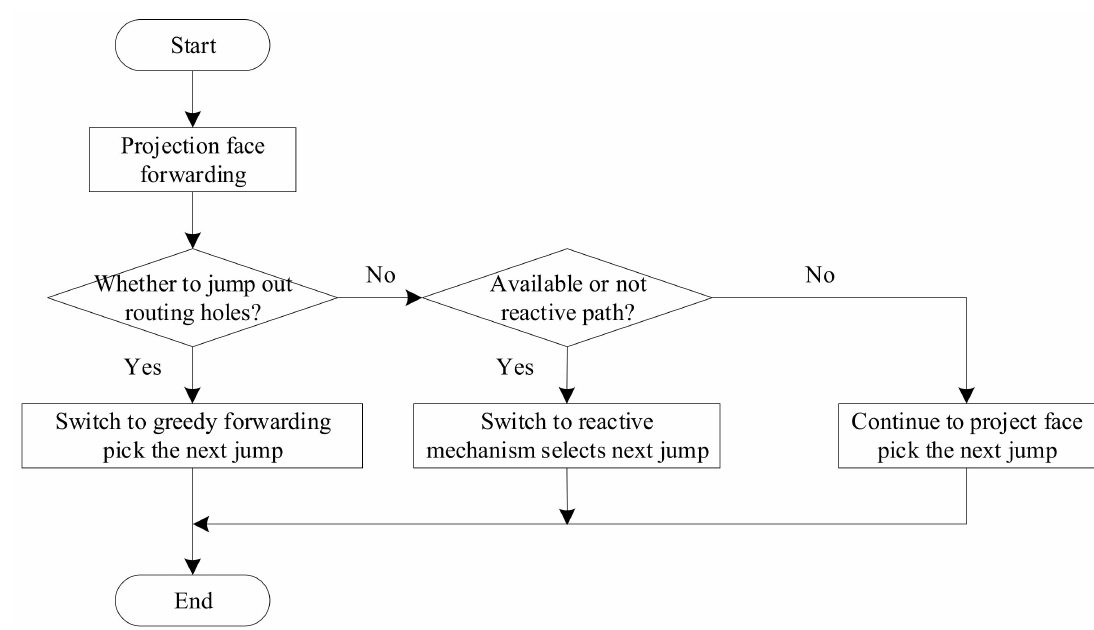
Figure 9. Switching conditions under the projection